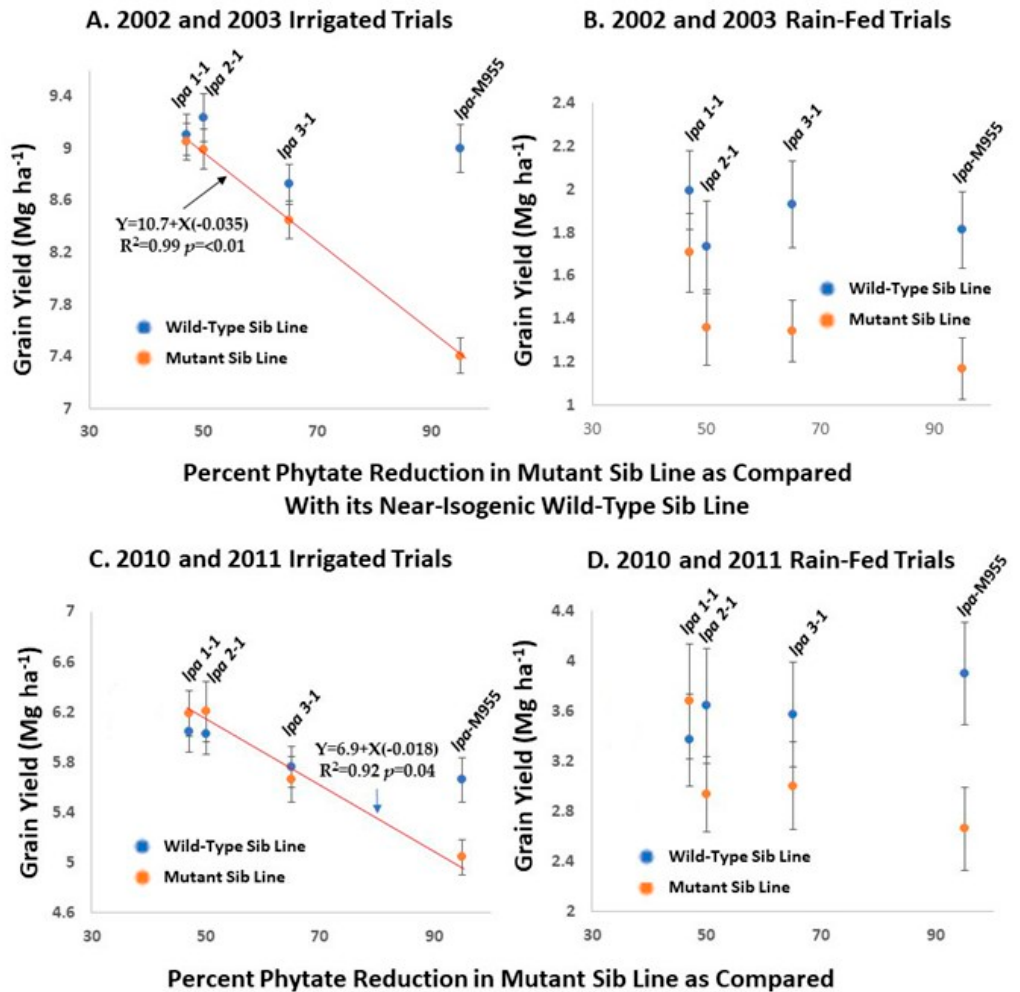
Figure 7. Two rounds of yield trials of barley low phytic acid ( lpa ) near-isogenic wild-type (normal phytic acid) lines, conducted in 2002 and 2003 and then in 2010 and 2011. Four pairs of near-isogenic lines, each pair consisting of a wild-type (normal phytic acid) sib and a lpa sib, were evaluated in several locations in Idaho (USA). These locations were either irrigated (two locations in 2002/2003 and three locations in 2010/2011) or rain-fed (non-irrigated; two locations in both 2002/2003 and 2010/2011) [27,89]. The homozygous lpa member of each isoline pair are: lpa 1-1, which conditions a ~47% reduction in seed phytic acid; lpa 2-1, which conditions a ~50% in seed phytic acid; lpa 3-1, which conditions a ~65% reduction in seed phytic acid; lpa -M955, which conditions a ~95% reduction in seed phytic acid. ( A , B ): Trials conducted in 2002 and 2003. ( C , D ): Trials conducted in 2010 and 2011. The error bars represent the standard deviation of the mean, or standard error, n = 12 to n = 36. Linear regression of yield against % phytate reduction (indicated by red lines) was calculated for the lpa isolines in the irrigated trials.